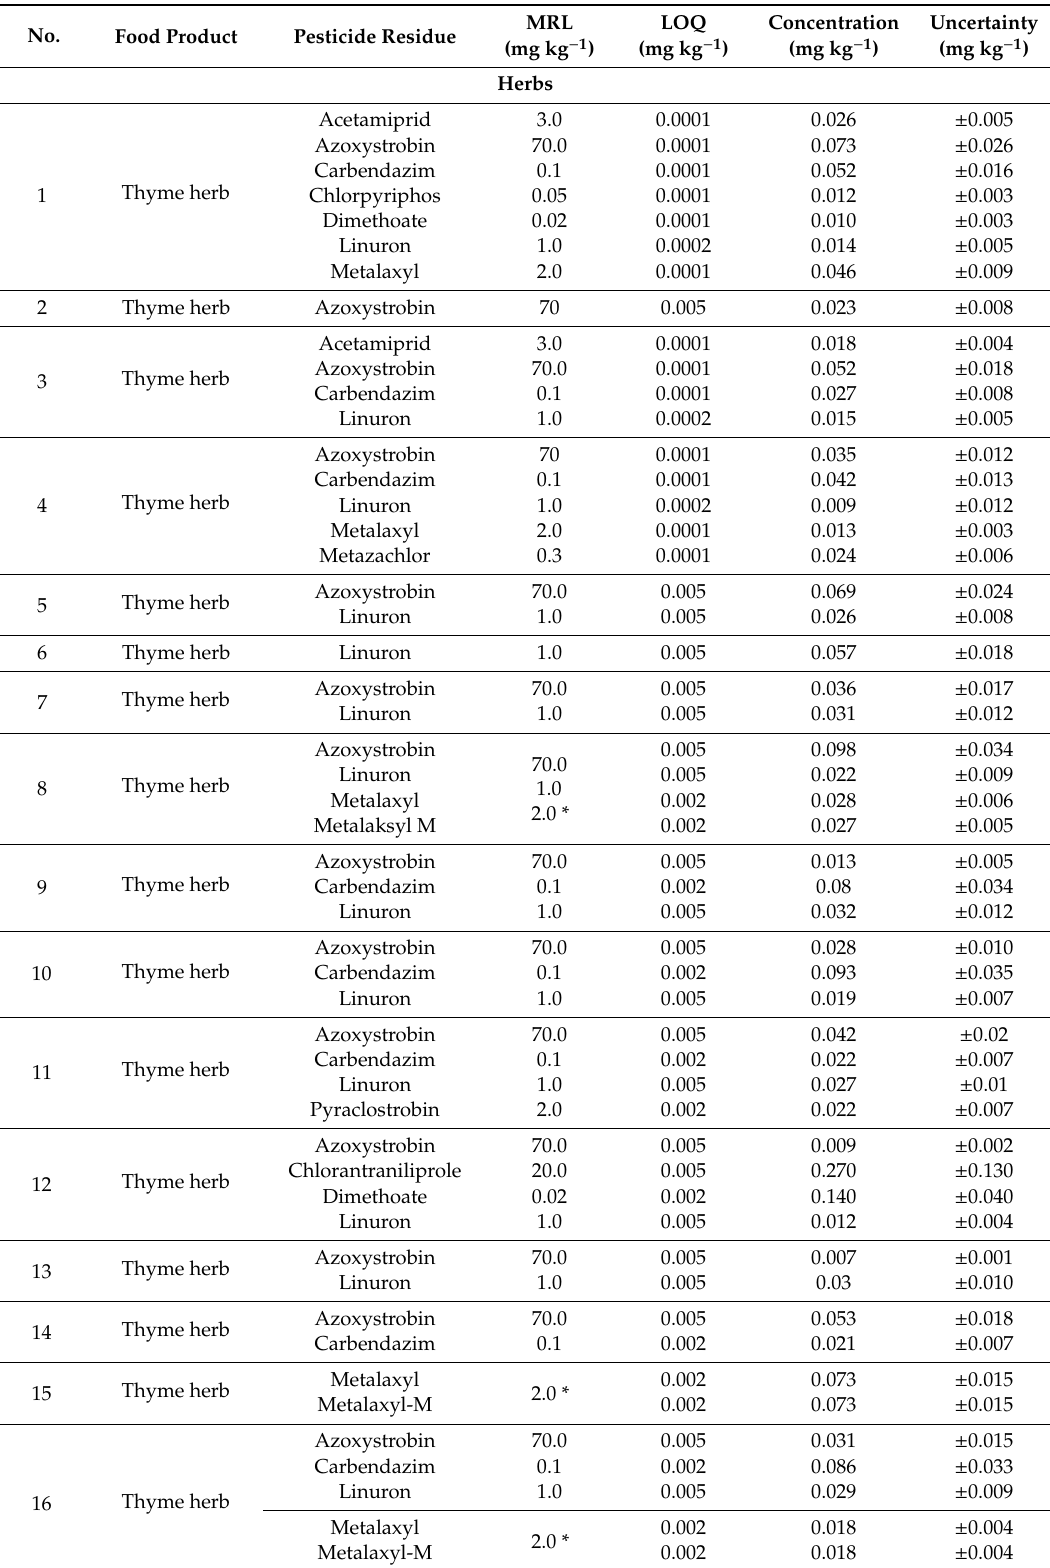
Table 2. Pesticide residues concentration in examined food